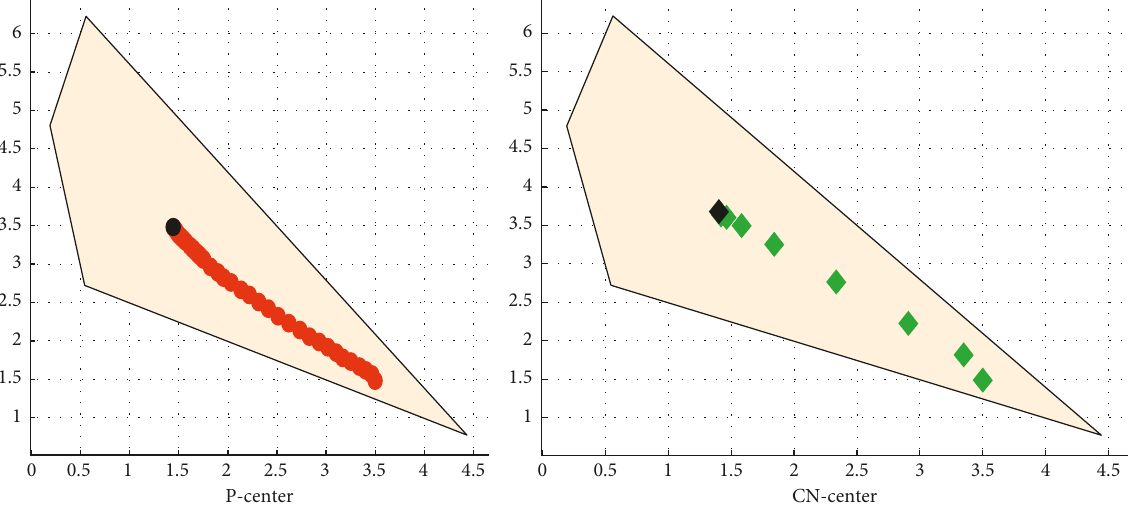
Figure 6: When initial point lies near a narrow corner, convergence of CN-center is much quicker than